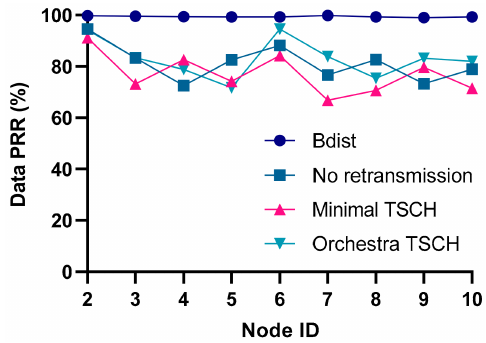
Figure 8. The PRR data of sensor nodes under several network